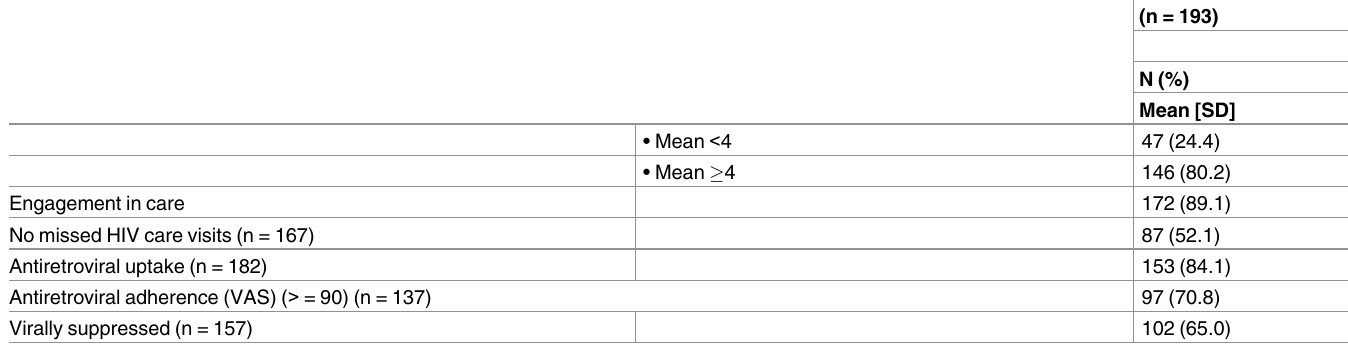
multivariable analysis (Table 3), having insurance (POR 6.74; 95% CI: 2.43, 18.74) and not using cocaine or crack (POR 5.87; 95% CI: 1.60, 21.48) were associated with ART